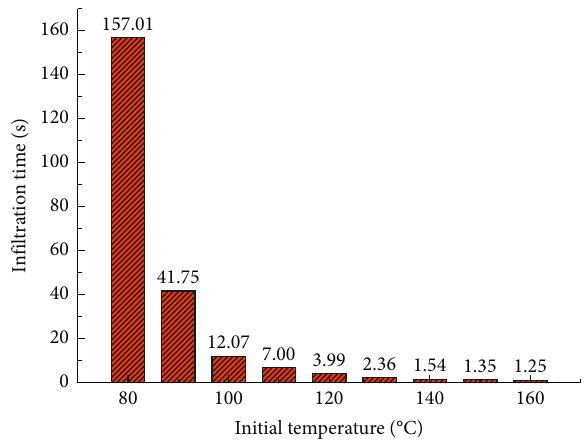
Figure 6: Infiltration ending time at different initial